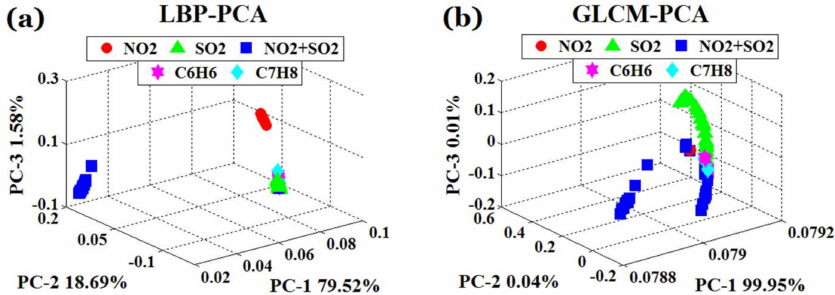
Figure 10. Principal component analysis (PCA) scattergram of different feature extraction algorithms. ( a ) PCA scatter diagram of the feature extracted based on LBP, ( b ) PCA scatter diagram of the feature extracted based on GLCM.